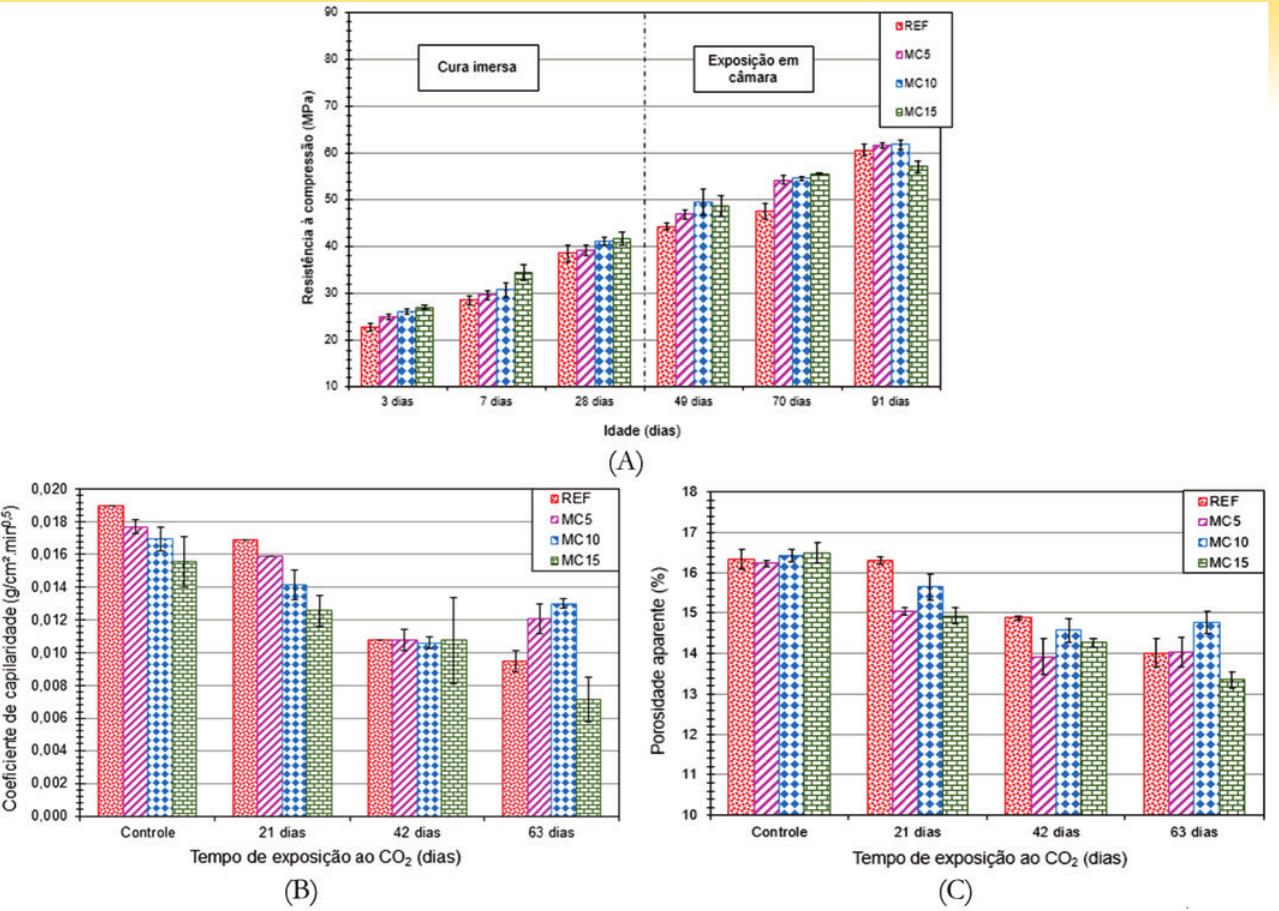
Figura 6 (A) Resistência à compressão, (B) Coeficientes de absorção capilar e (C) Porosidade aparente de corpos de prova contendo diferentes teores de metacaulim e em diferentes idades de exposição em câmara de CO 2